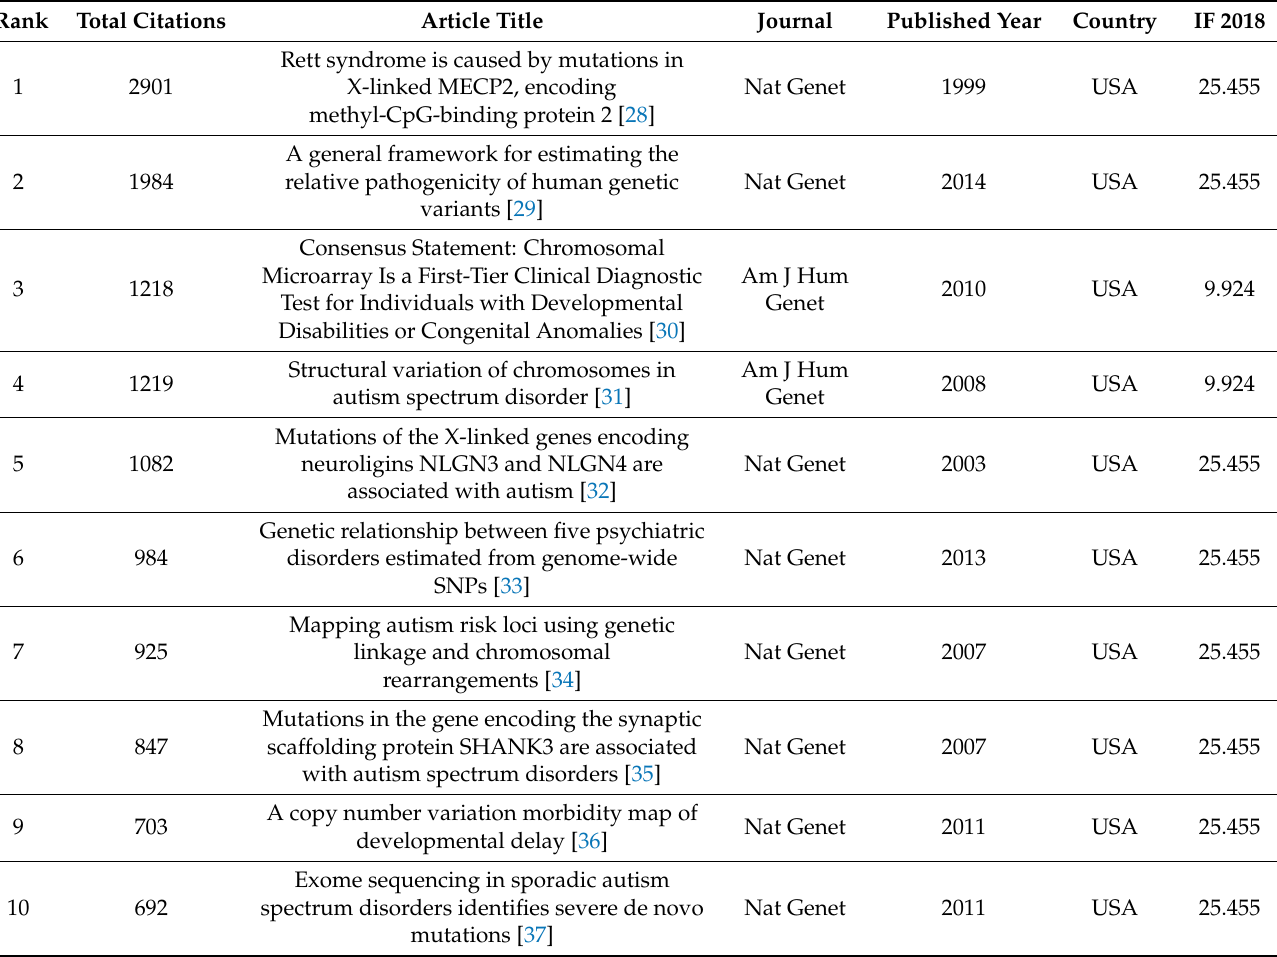
Table 3. The characteristics of highly cited